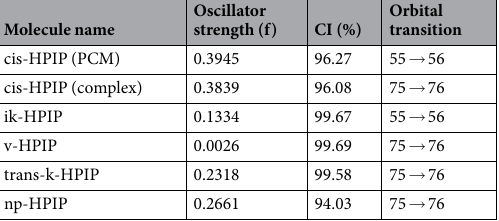
Table 5. The corresponding oscillator strength (f), contribution index (CI) and orbital transition for the different molecular structures in the S 0 → S 1